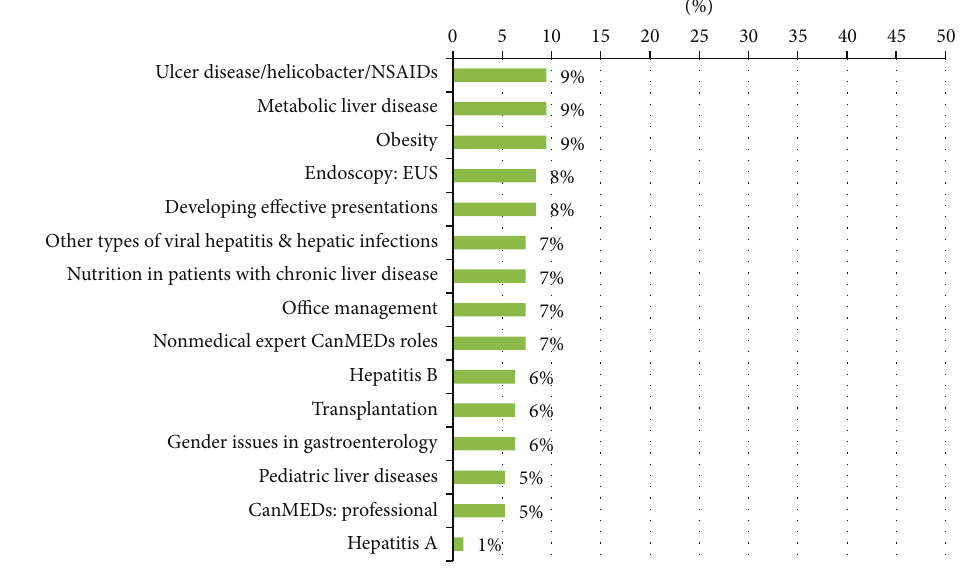
Figure 4: Educational topics in which 1–9% of respondents were “very interested.” NSAIDs: nonsteroidal anti-inflammatory drugs; EUS: endoscopic